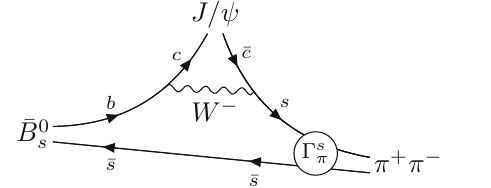
Fig. 3 Tree-level W -exchange diagram for the decay process ¯ B 0 s → J /ψ π + π − .Thehadronizationofthe ¯ ss quarkpairinto π + π − ( S -wave dominated) is given by the scalar form factor Γ s π